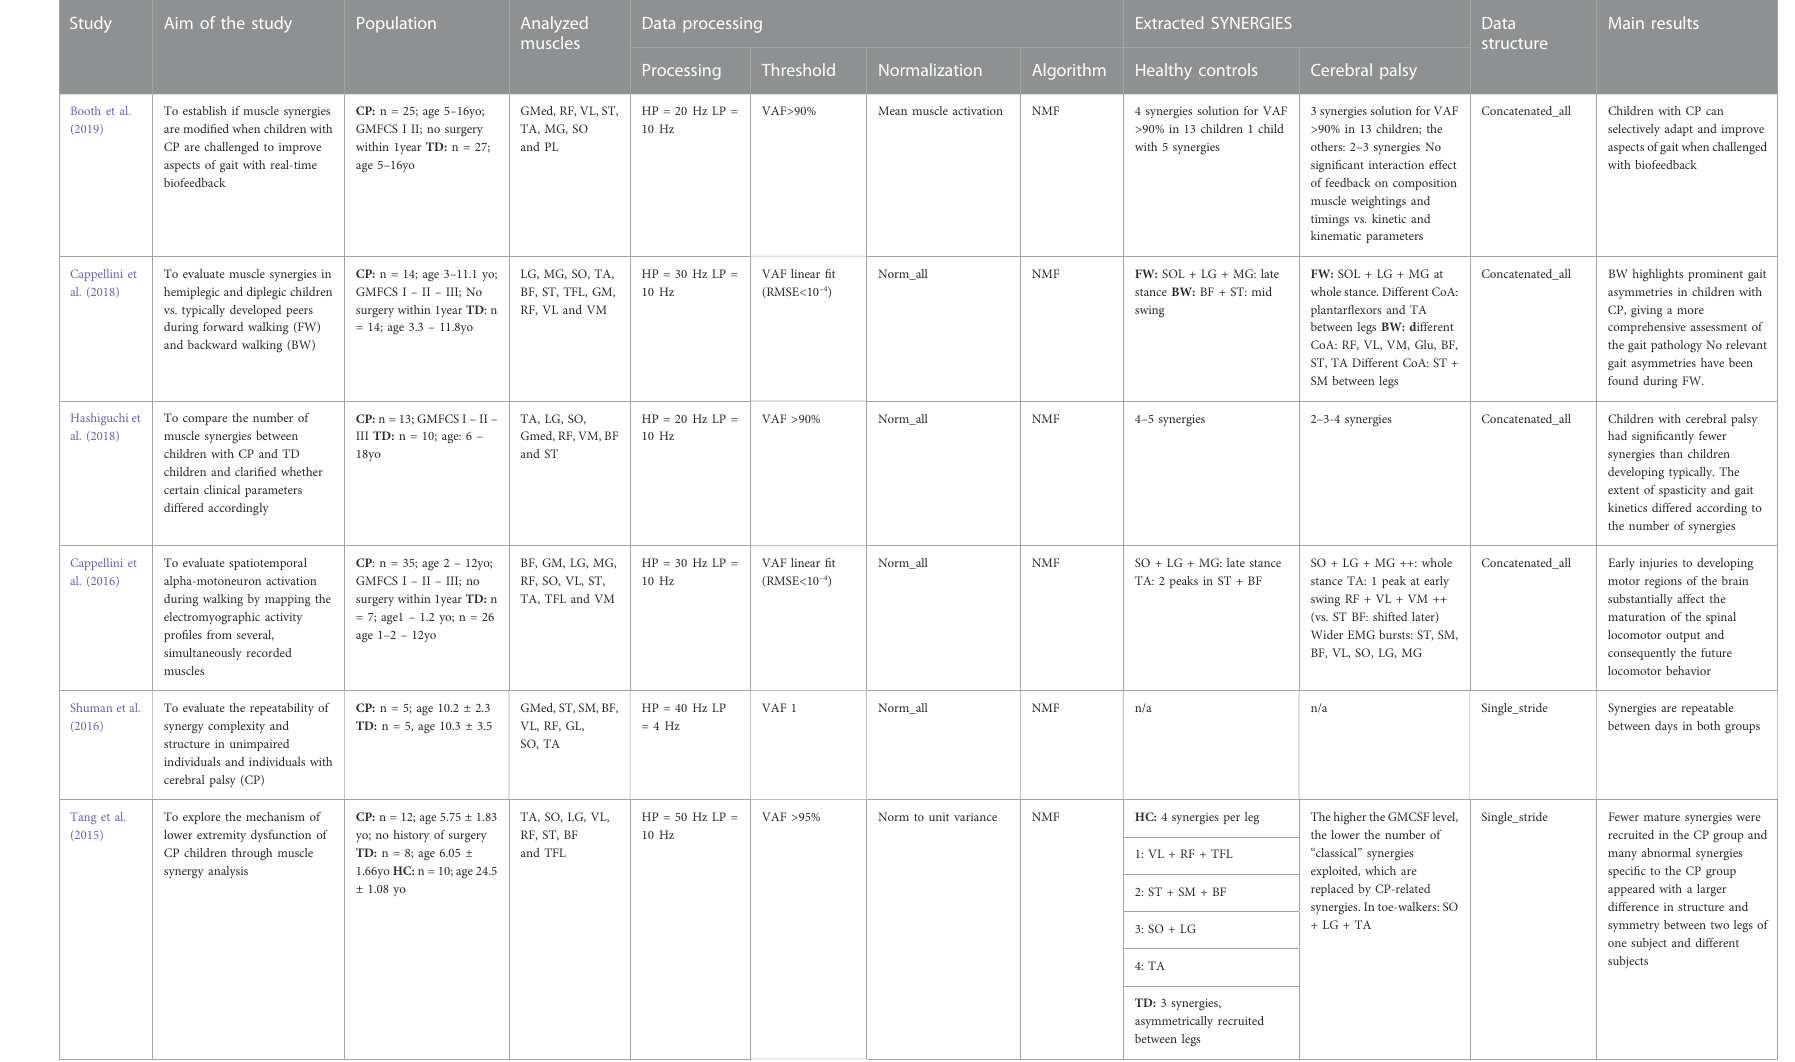
TABLE 1 ( Continued ) Aim of the study, population, analyzed muscles, data processing, data structure, extracted synergies, main results of the articles investigating how muscle synergies vary in children affected by Cerebral Palsy (CP) in respect to healthy subjects. Acronyms: CP: cerebral palsy, TD: typically developed, HC: healthy controls, GMFCS: Gross Motor Function Classi fi cation System, BW: backward walking, FW: forward walking, SDR: selective dorsal rhizotomy, BoNT-A: Botulinum Toxin Type-A, GM: gluteus maximum; Gmed: Gluteus medius; BF: biceps femoris; ST: semitendinosus; SM: semimebranosus; RF: rectus femoris; VL: vastus lateralis; VM: vastus medialis; TA: tibialis anterior; PL: peroneus longus; EHL: extensor hallucis longus; SO: Soleus; ES: erector spinae; TFL; tensor fasciae latae; MG: medial gastrocnemius; LG: lateral gastrocnemius; GR: gracilis; RA: rectus abdominis, NMF: Non-negative matrix factorization, RMSE: Root mean square error, HP: high pass fi lter, LP: low pass fi lter, WNMF: weighted-NMF, Walk-DMC: dynamic motor control index during walking, VAF: Variance Accounted For. Data processing Extracted SYNERGIES Data Main results structure Processing Normalization Algorithm Healthy controls Cerebral